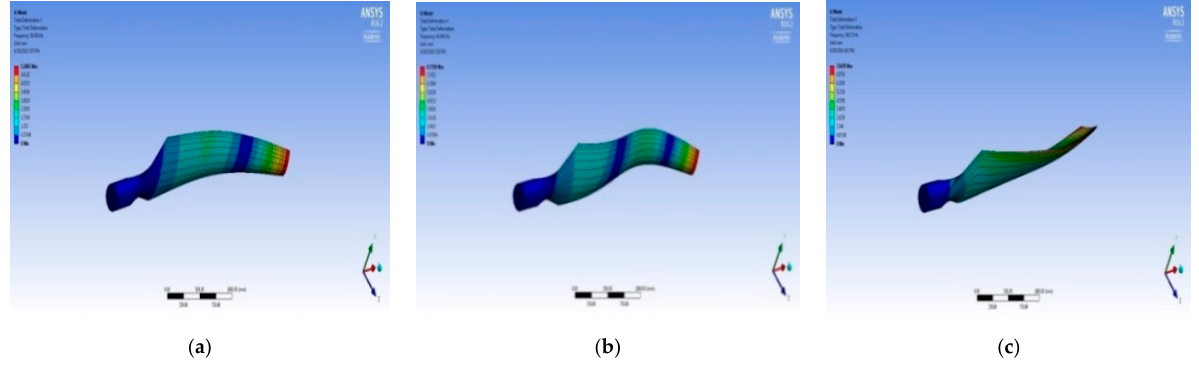
Figure 20. Deformed structures of titanium alloys, GFRP, and KFRP, respectively. ( a ) Vibrational displacements of wind turbine blade imposed with Titanium-alloy. ( b ) Vibrational displacements of wind turbine blade imposed with GFRP. ( c ) Vibrational displacements of wind turbine blade imposed with KFRP.